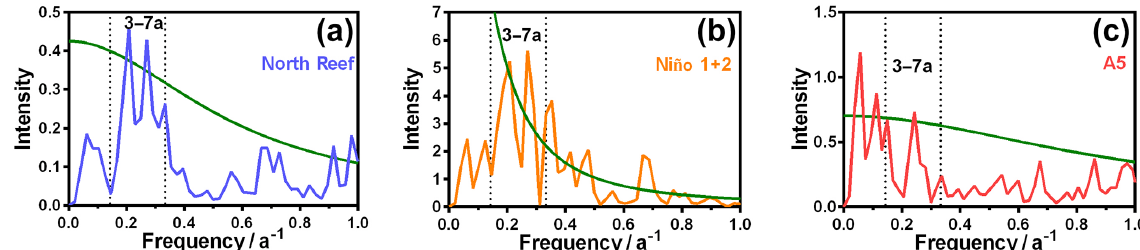
Figure 7. Spectral analysis of the North Reef SST anomalies (a) , Ninõ 1 + 2 SST anomalies (b) , and reconstructed SST anomalies according to δ 18 O A5 (c) . Green lines indicate significance at the 90% confidence level, and the area between the two dotted lines represents the frequency of 3 to 7 years.